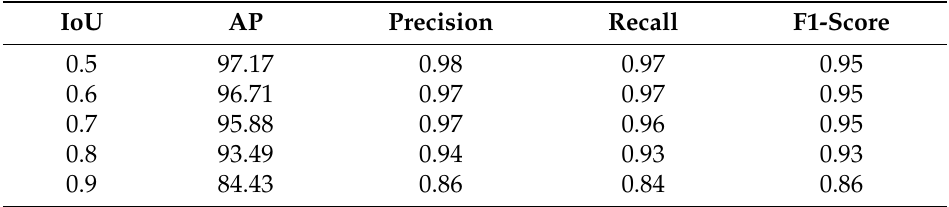
Table 5. The model performance results for ConvNeXt+DyHead backbone with Faster-RCNN (bbox) on